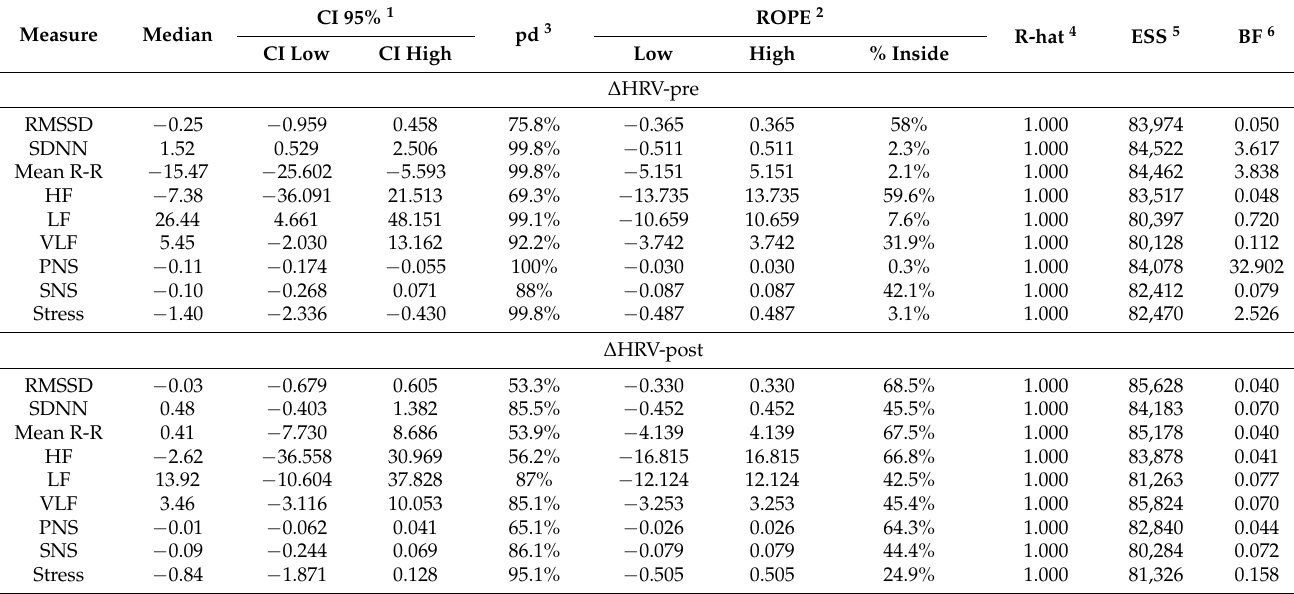
Table 2. Summary and model diagnostics for each HRV measurement within TMST assessments. CI, credible interval; pd, probability of direction; ROPE, region of practical equivalence; ESS, effective sample size; BF, Bayes factor.